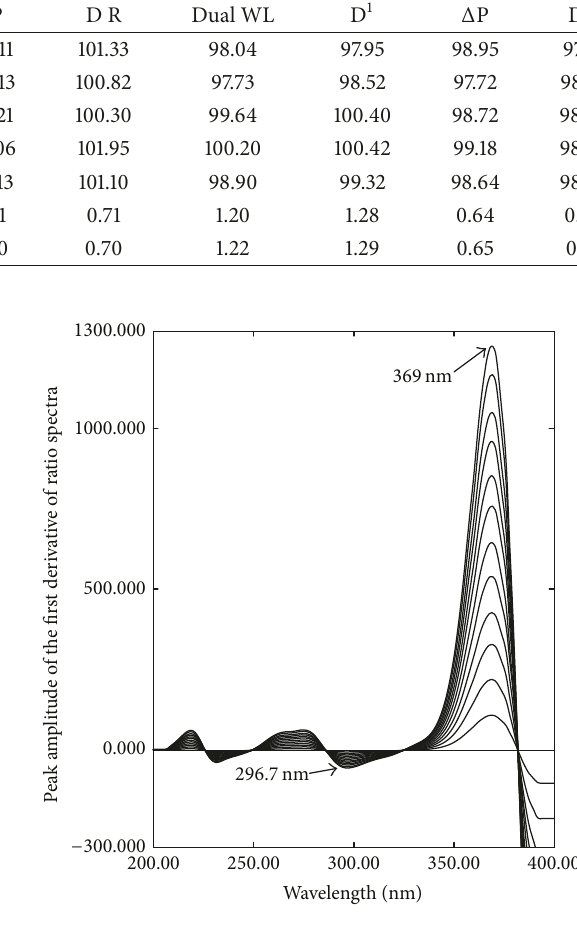
Figure 6: First derivative of ratio spectra of OXY (5–60 𝜇 g/mL) using normalized divisor of FLU and 0.1 NHCl as a